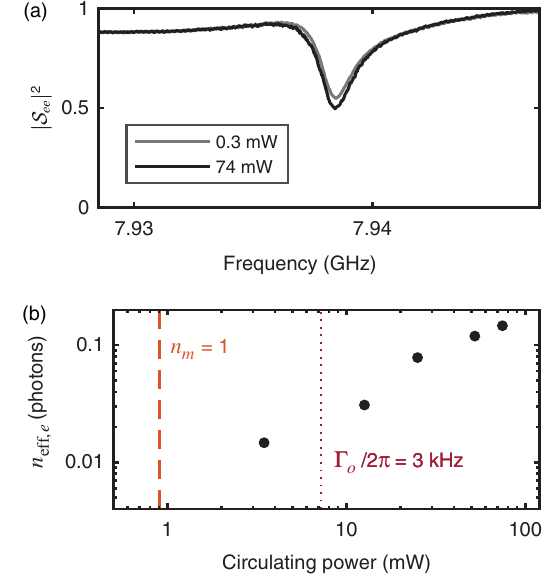
FIG. 4. Effects of laser illumination on microwave